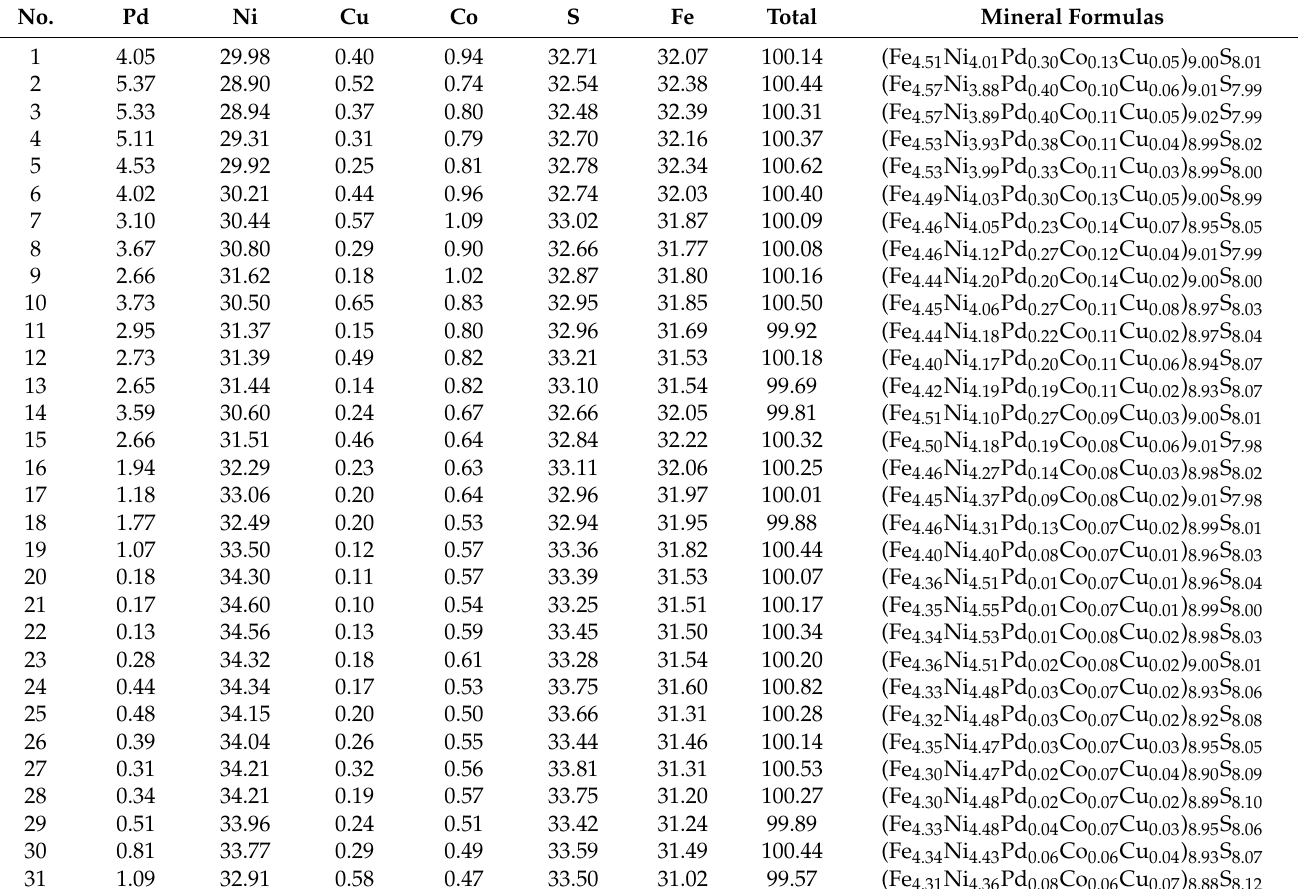
Table 5. Compositional variations in the crystal of Pd-rich pentlandite (wt.%) along the profile LL’.